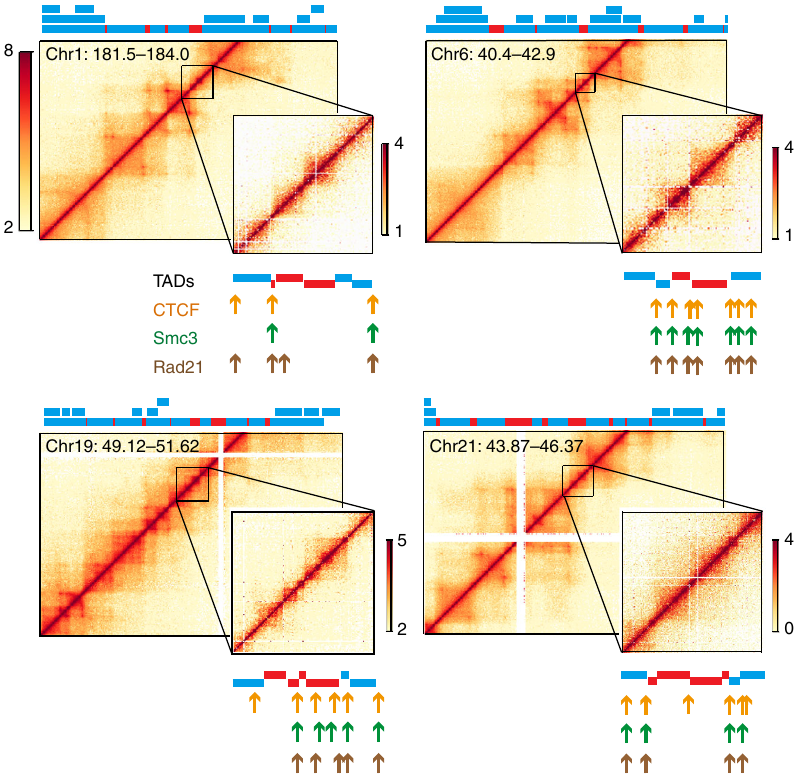
Fig. 4 The human genome is also partitioned into contiguous small TADs within previously described “ inter-TAD ” regions at least in part. Shown are four examples of Hi-C data of GM12878 lymphoblastoid cells determined by Rao et al. 24 In each panel, the main fi gure is the heatmap of the indicated chromosomal position at 5 kb resolution, with the domains annotated by these authors indicated by the color bars above each fi gure. Note that there were smaller TADs within larger TADs identi fi ed in this previous work, re fl ected in the three different levels in the annotated TADs. The bars colored red re fl ect the inter-TAD regions, while those colored blue are the TADs. The inset of each panel is an expanded region of an inter-TAD region. The TADs annotated using the Armatus software are shown below the heatmap. Also shown are the locations of CTCF (orange arrows) and cohesin components ( Rad 21 and Smc3, green and brown arrows. respectively), as determined previously